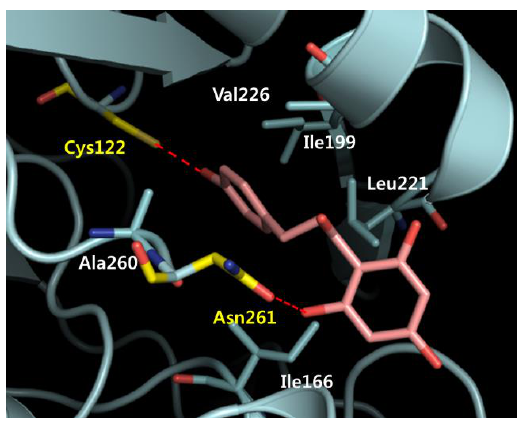
Figure 9. Binding of phloretin and mtKASIII. Hydrophobic residues and those participating in hydrogen bonding are shown in white and yellow, respectively.